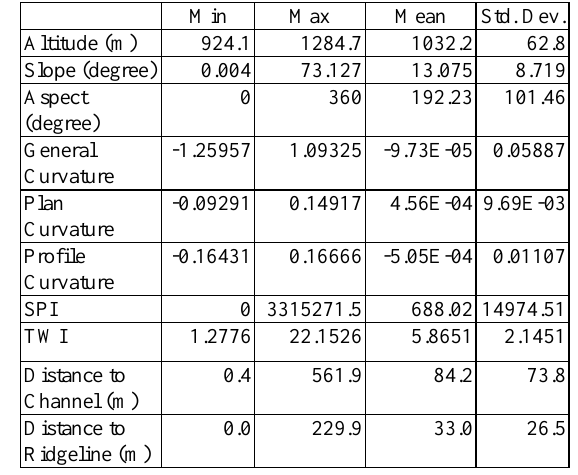
Table 1. Statistics of topographic attributes